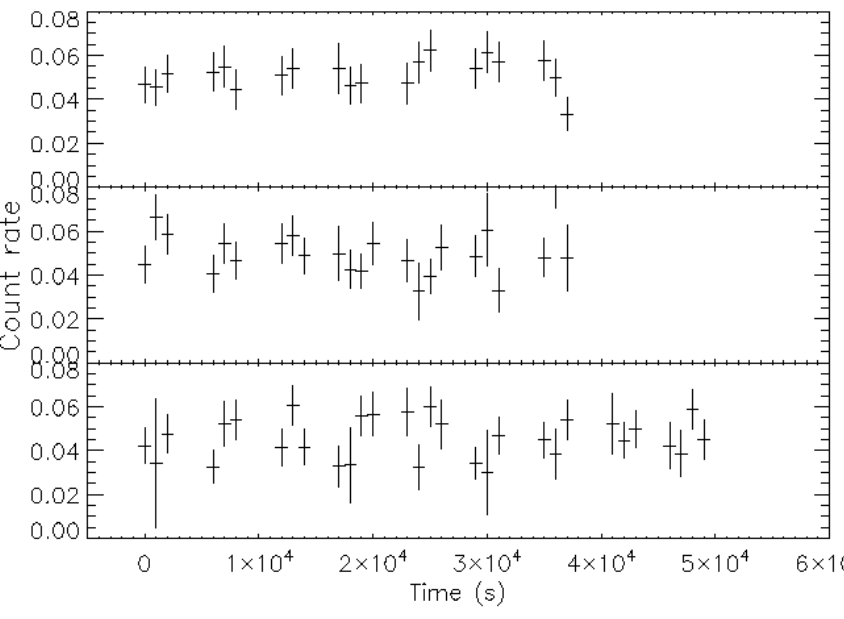
Figure 6. NuSTAR light curves for the energy range 20–60 keV from data collected in 3 November 2015 ( top panel ), 1 February 2017 ( middle panel ) and 4 February 2017 ( bottom panel ). Light curves are binned over 1000